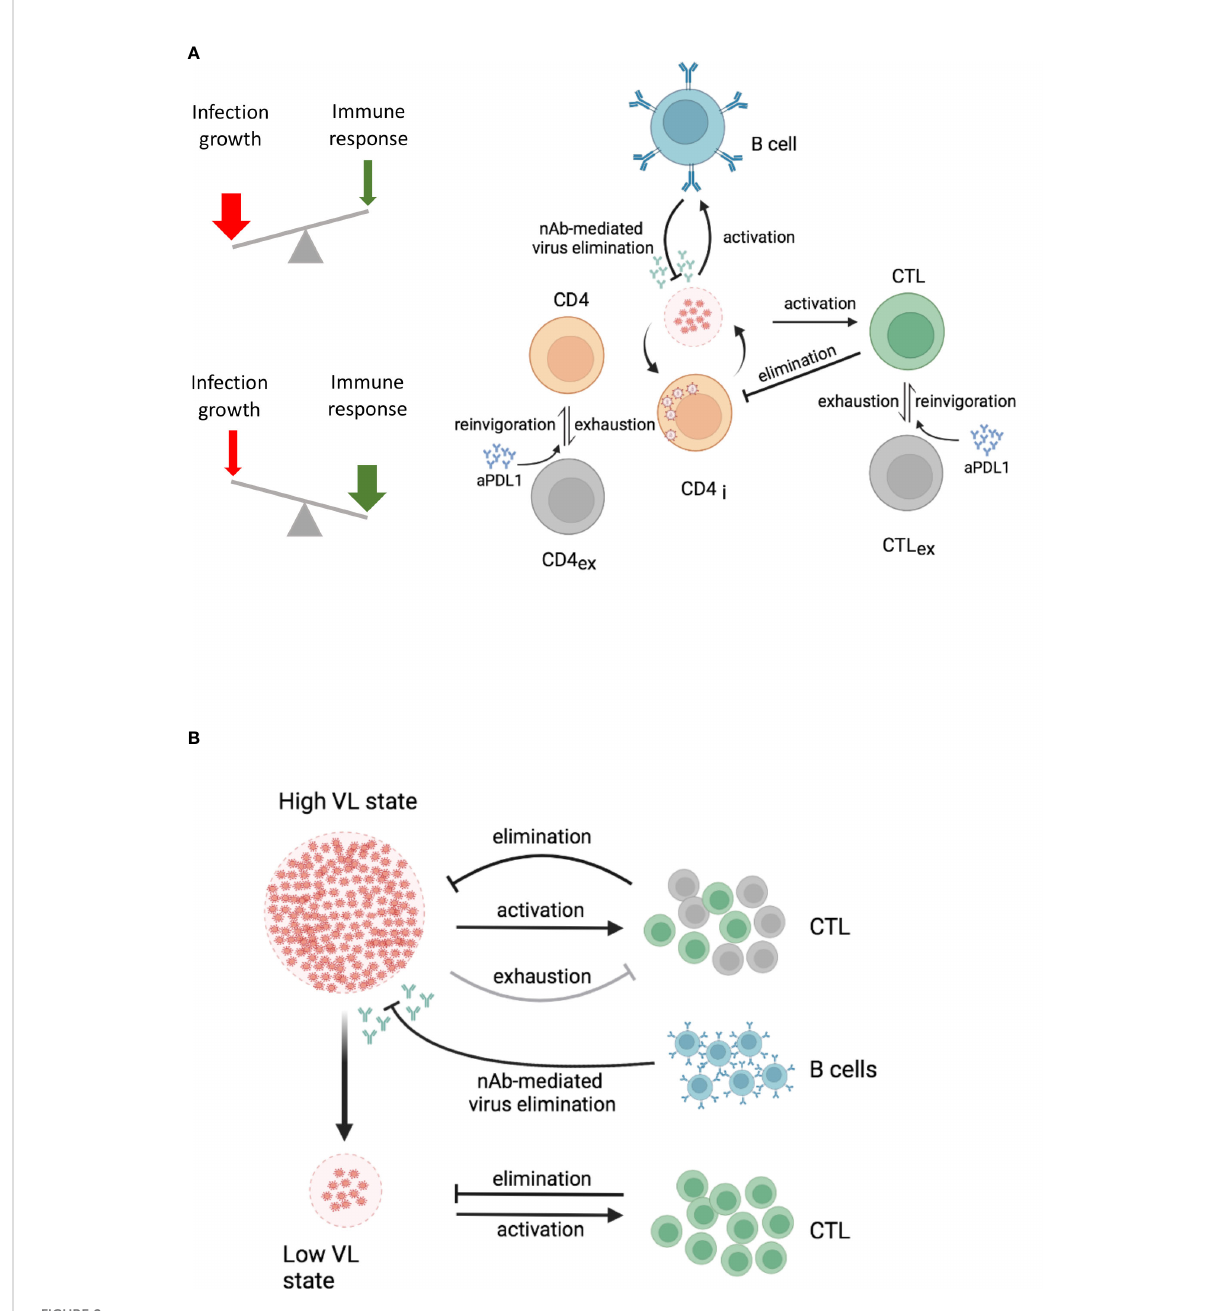
FIGURE 2 Dynamic views of virus-host interactions. Lines with an arrow or T end represent expansion or reduction/suppression of the corresponding virus or cell populations, respectively. The speci fi c processes by which this occurs are speci fi ed above the lines. (A) Conceptual dynamic view of a high and a low virus load state within an infected host. The underlying processes are indicated. A high VL state drives CTL exhaustion (grey cells) and reduces the population of effector CTL (green cells). B cells (blue cells) produce antibodies that eliminate infectious viruses. Both, effector CTL and antibodies from B cells, depending on their strength, contribute to the control of the virus load. (B) Cooperative engagement of individual immune components for functional cure strategies in HIV-1 infection. The combination of immune checkpoint inhibitors with CTL- based immunotherapy and neutralising antibody responses is indicated. aPDL1, anti-PDL1 antibodies; CTL, cytotoxic T cells; CTLex, exhausted CTL; CD4i, infected CD4 T cells; VL, virus load. The fi gure was created with